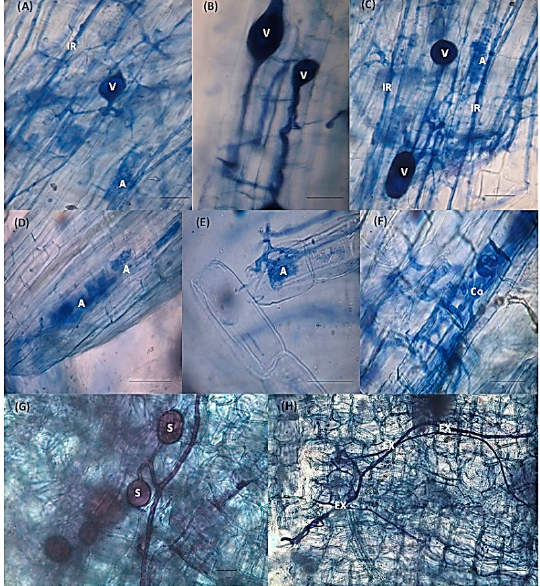
Figure 6. Mycorrhizal root colonization patterns of 56-day-old tomato plants inoculated with mycorrhizae and n-HAP and infected with M. incognita : ( A – C ) showed vesicles “V”, intraradical hyphae “IR”, and arbuscules “A”; ( D , E ) showed arum-type of arbuscules; ( F ) showed hyphal coils “Co”; ( G ) showed spores of Rhizophagus aggregatus colonizing the host tomato root “S”; and ( H ) showed extraradical hyphae “EX”. Bar, 50 µm.